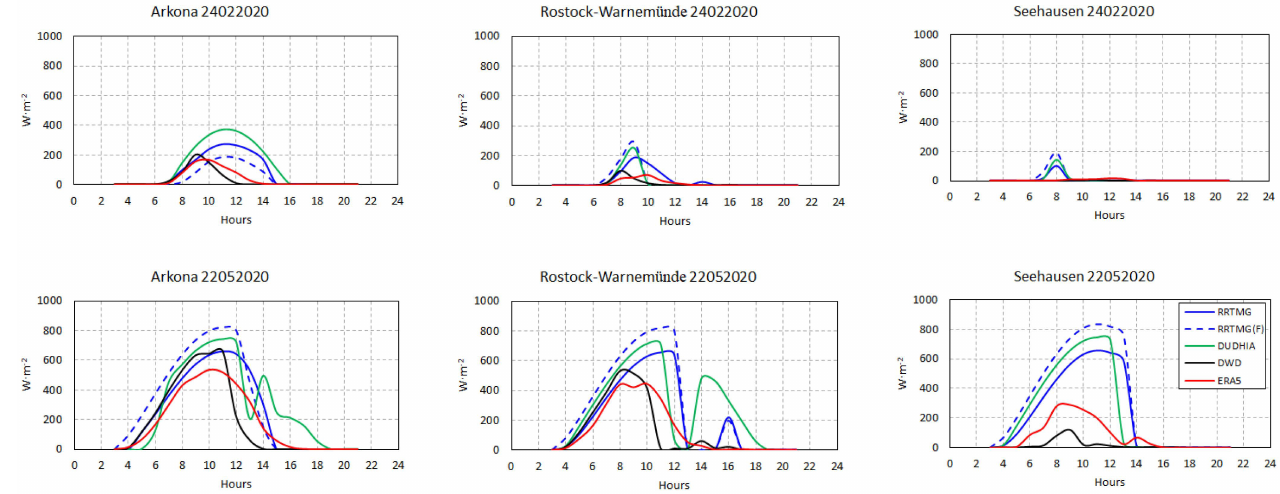
Figure 10. Diurnal distribution of the direct radiation values for the warm fronts.